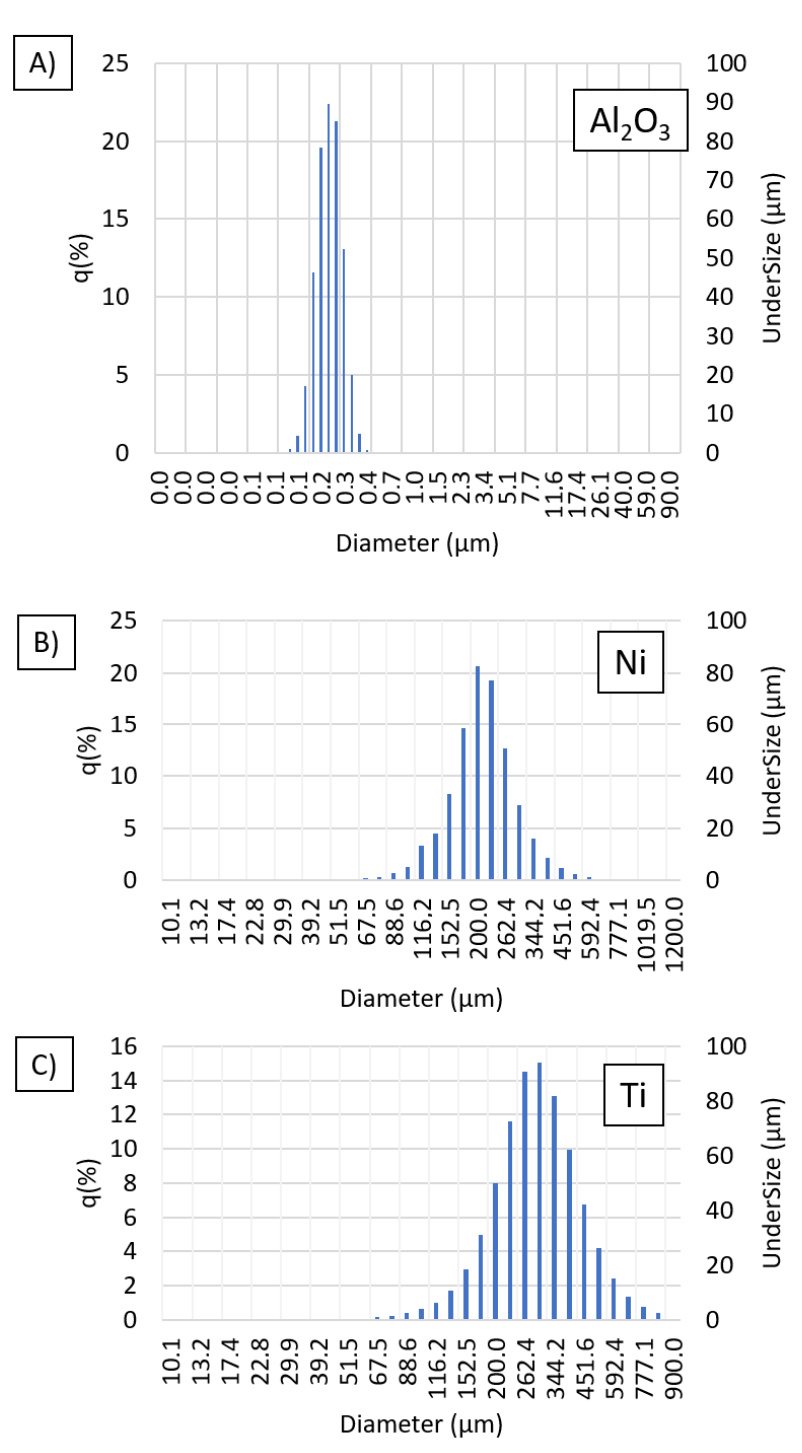
Figure 1. Histogram of particle size distribution results for ( A ) alumina powder, ( B ) nickel powder, and ( C ) titanium powder.